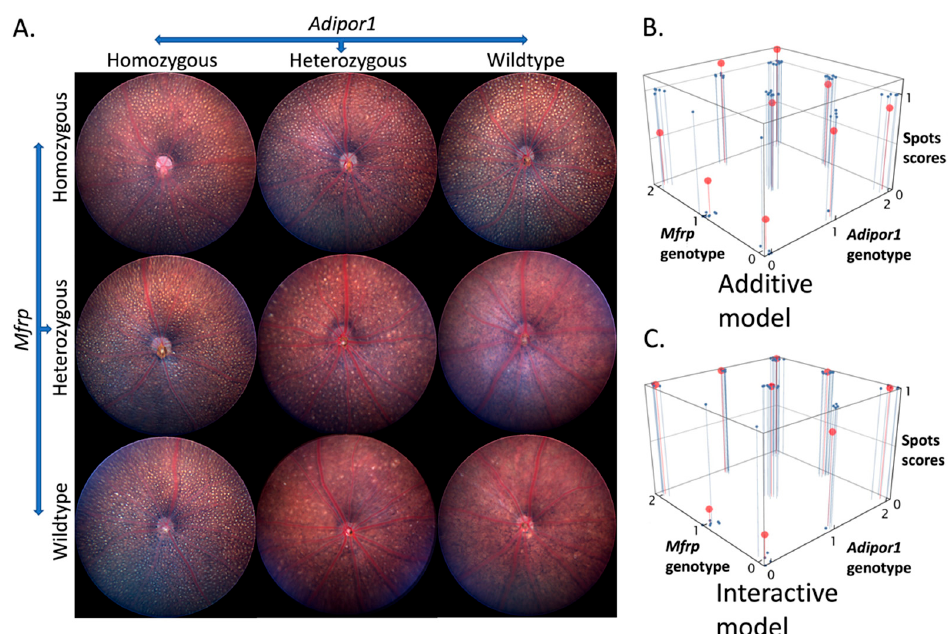
Figure 2. Fundus spots in 4-month-old F2 progeny, obtained from ( Adipor1 +/ − / Mfrp +/rd6 ) F1 intercross. ( A ) Fundus photographs for mutants bearing one of the nine possible combinations of mutations, showing the presence of fundus spots in single and double homozygous mutants as well as double heterozygous mutants. Spots were also observed in heterozygous Adipor1 +/ − mice. ( B ) Linear fit model without interactions and ( C ) linear fit model with interactions, showing actual data in blue and model predictions in red. The Adipor1 and Mfrp genotypes along the two axis represent independent variables and the alleles are scored as: wildtype—0, heterozygous—1, and homozygous— 2. The scores for fundus spots along the third axis represent response variables and are scored as 0 or 1. Model predictions have a better fit with the actual data in the interactive model as compared to the additive model, confirming an interactive effect. n = 5–10 per genotype.